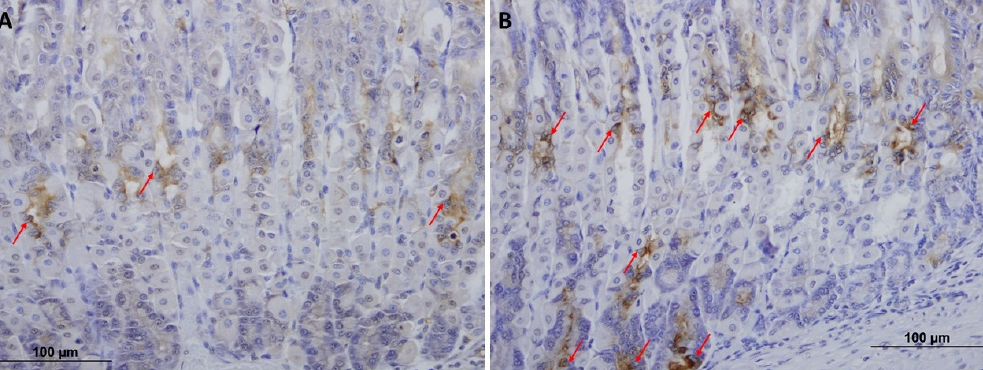
Figure 6. TFF2-labeled epithelial cells (arrows) in tissue sections obtained from the middle and basal portions of the gastric mucosae of control ( A ) and VSL-treated ( B ) mice. Note the extension of TFF2 labeling to the bottom of the gastric glands where chief cells (lower three arrows) are located. Magnification bar = 100 µm.